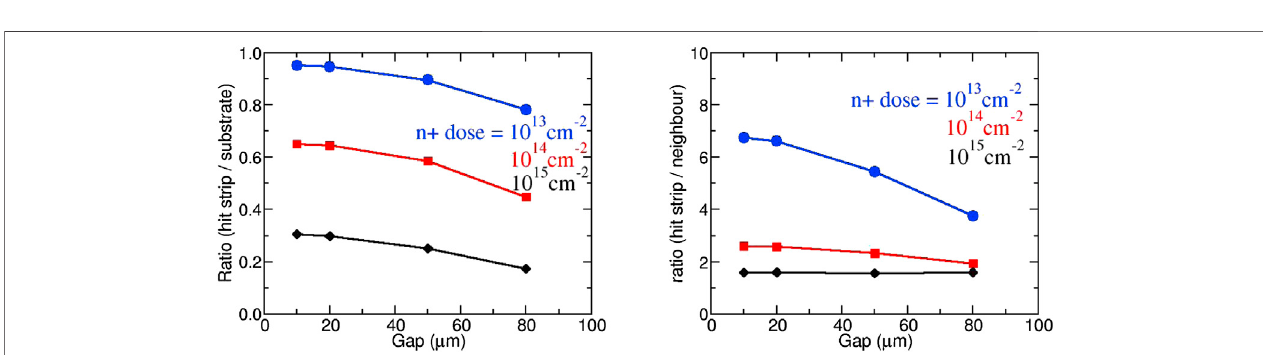
FIGURE13| Left,ratioofcurrentpulseamplitudesatthesubstrateandatthehitelectrodeasafunctionofthegapbetweenelectrodes,fordifferent n + implantation doses, in the simulated example of AC-LGAD. Right, for the same example, ratio of amplitudes for hit strip and neighbor strip.